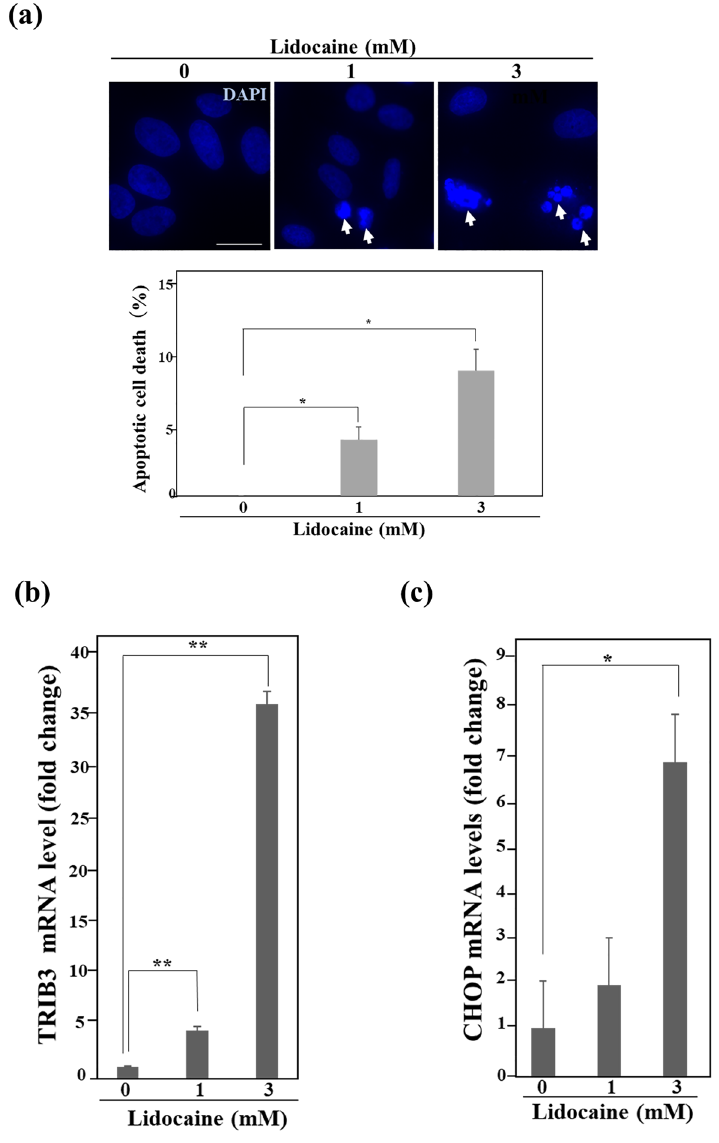
Figure 5. Lidocaine induces apoptosis and TRIB3 expression. ( a ) Number of apoptotic cells with chromosome condensation. Nuclei of HeLa cells treated with the indicated concentration of lidocaine for 24 h were stained with DAPI. The arrows indicate condensed chromosome. Each sample of one hundred cells was counted in triplicate. The number of apoptotic cells increased with lidocaine treatment in a concentration-dependent manner. The scale bar represents 10 μm. The results are presented relative to the total cell number and mean ± SD. * p < 0.05. ( b ) and ( c ) The level of TRIB3 and CHOP mRNA in qPCR. Total RNAs purified from HeLa cells treated with the indicated dose of lidocaine for 24 h were used for reverse transcription and qPCR analysis using TRIB3 or CHOP primers. The results were normalized by the expression levels of GAPDH at the indicated lidocaine concentration. The level of TRIB3 and CHOP mRNA increased with lidocaine treatment in a lidocaine-concentration dependent manner. Each sample was assayed in triplicate and the results are presented as the mean ± SD. * p < 0.05, ** p <